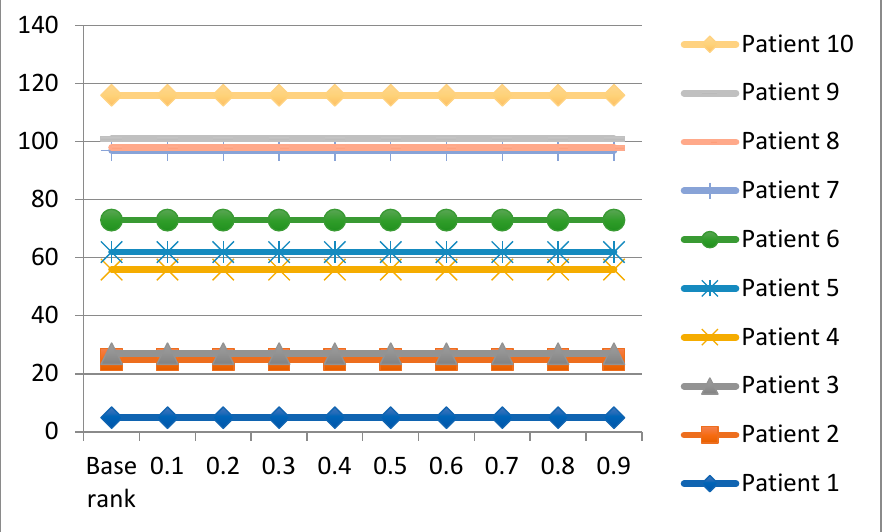
Figure 4. Sensitivity analysis of V value for 10 patients.